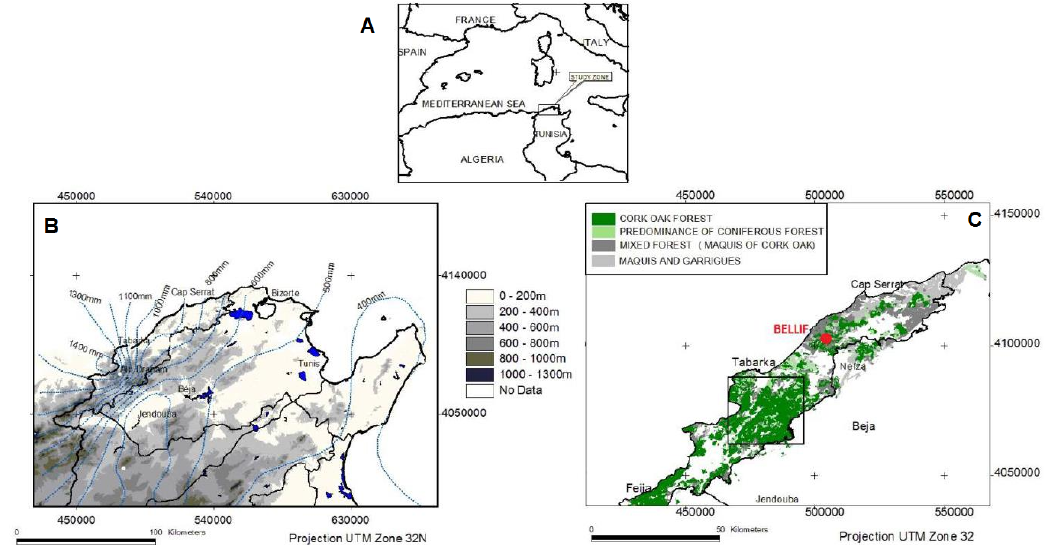
Figure 1. Location of the study area (Bellif national forest) in the Mediterranean basin ( A ). Altitude and precipitation isohyets ( B ) and forest cover types ( C ) are also shown.